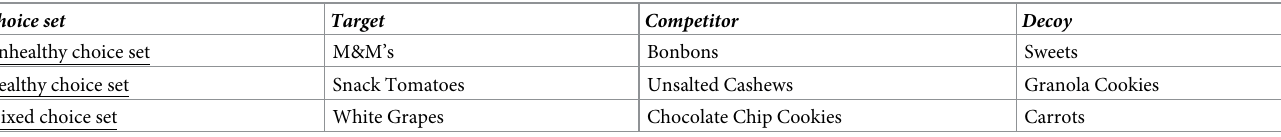
Table 1. Choice sets main